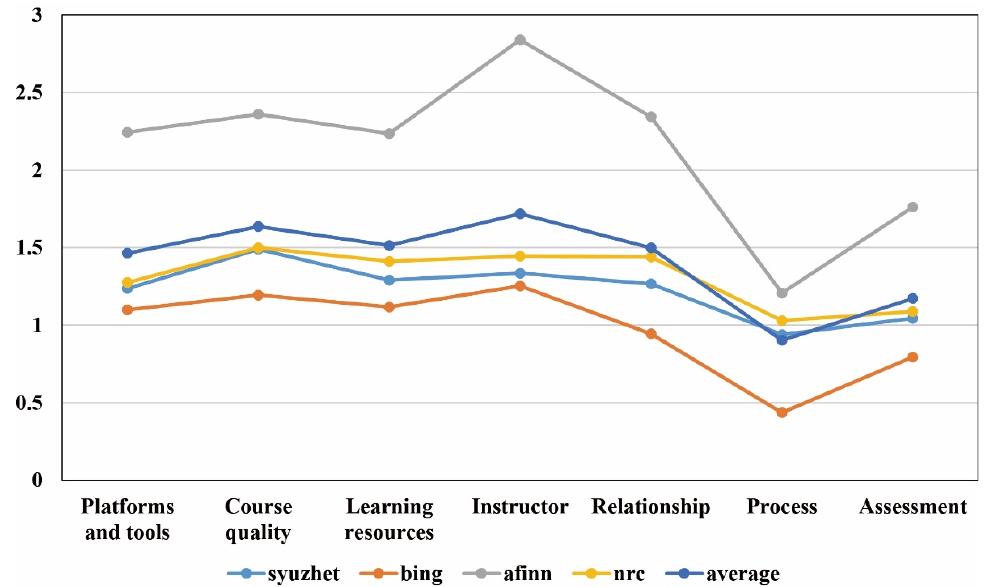
Figure 10. Averaged overall sentiment scores for each topic (calculated based on different method- ologies).